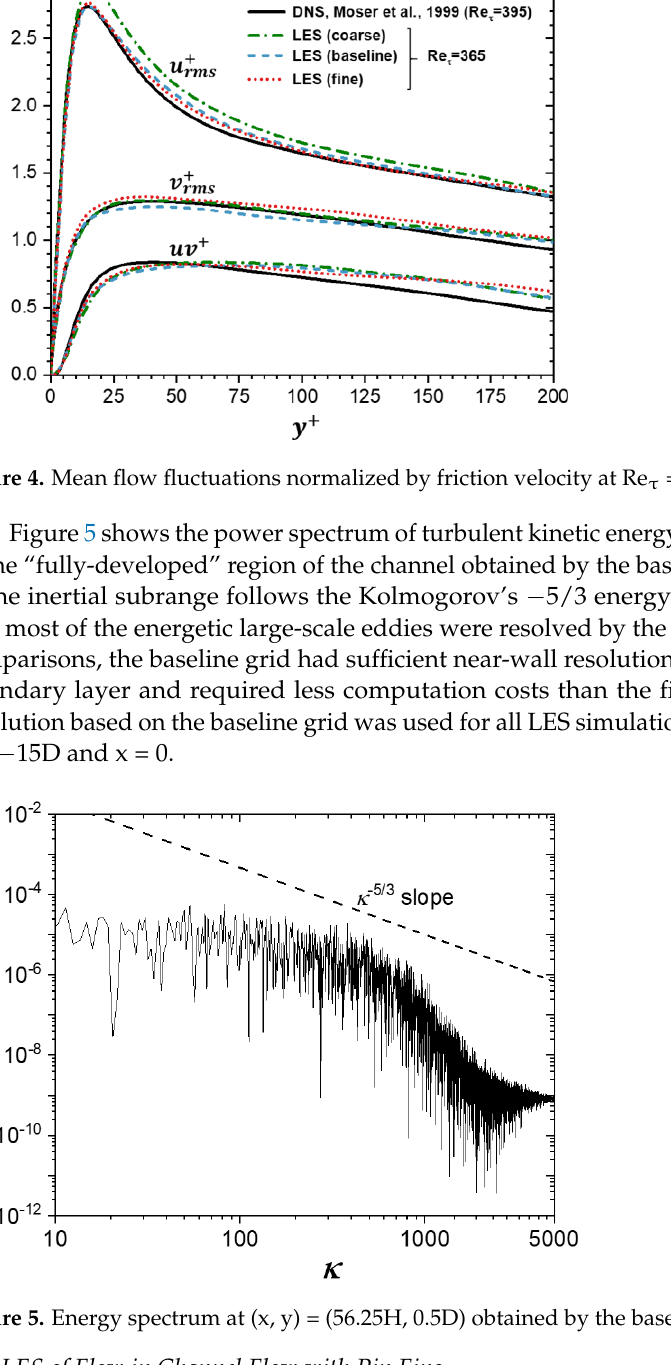
Figure 5. Energy spectrum at (x, y) = (56.25H, 0.5D) obtained by the baseline grid.